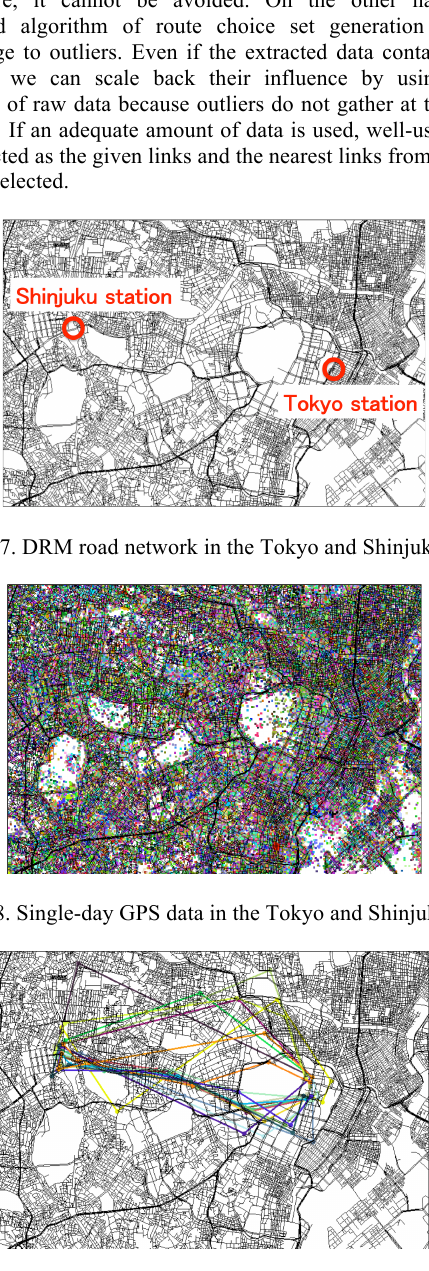
Figure 9. Data extracted by proposed data processing